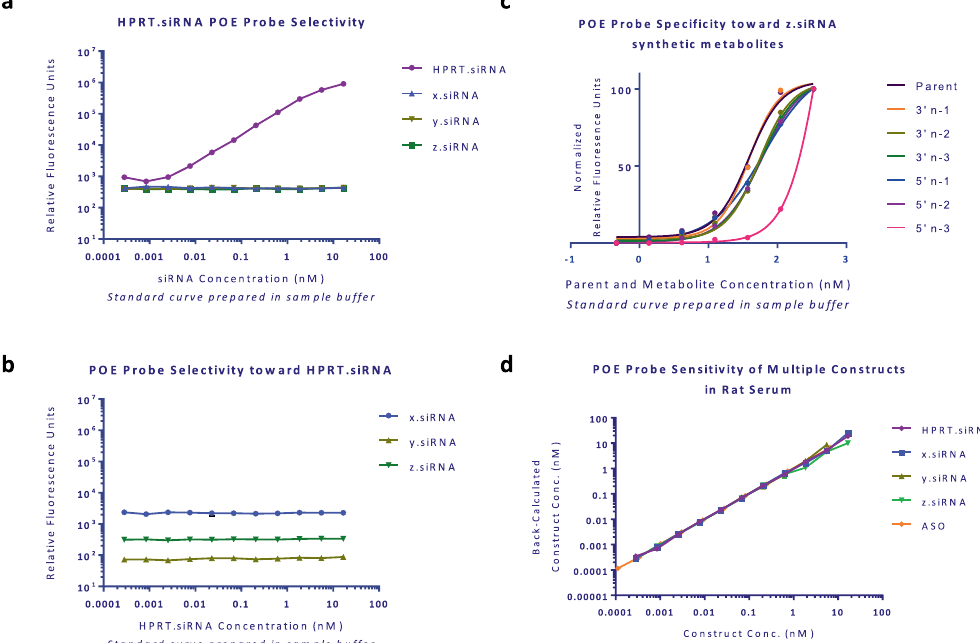
Figure 2. Assay selectivity of POE immunoassay probes holding capture and detection reagents constant with varying test article ( a ) and holding test article constant with varying detection reagents ( b ). Specificity of POE immunoassay probes against synthetic metabolites of z.siRNA ( c ).The assay is selective for 3 ′ and 5 ′ n-1 and n-2 metabolites with decreased reactivity with n-3 metabolites. EC 50 values are shown in Supplementary Information. Normalized data represented with a nonlinear curve fit. Sensitivity of POE immunoassay probes for multiple constructs were assessed in rat serum with a dynamic range of 0.3 to 16,700 pM siRNA and 0.1 to 6,640 pM ASO ( d ). Mean data from A, B, and D shown with error bars representing standard deviation.